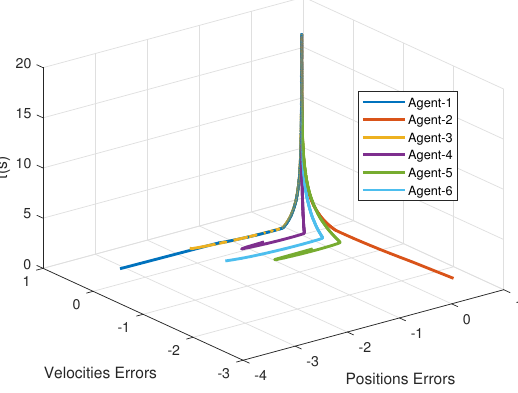
Figure 4. The second-order consensus under the proposed control